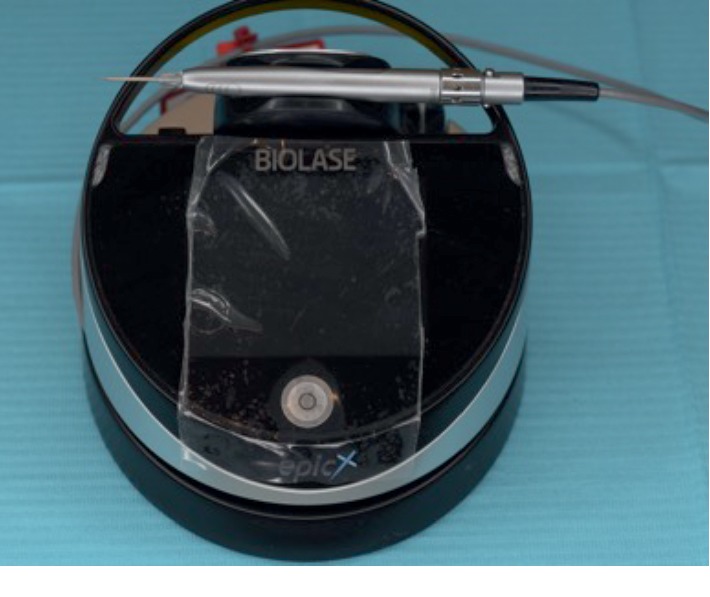
Epic, biolase 940 nm.